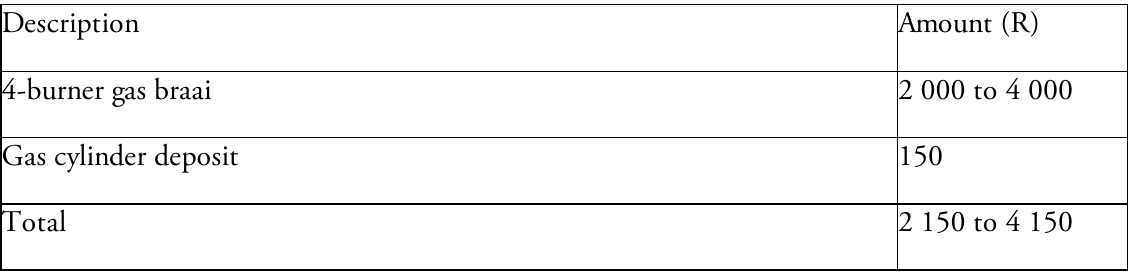
Table 7: Costs of the capital equipment for switching from wood braais to gas braais